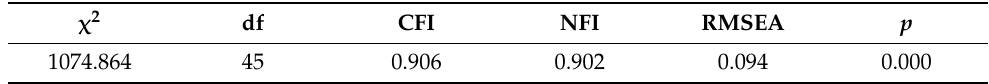
Table 1. Goodness of fit indexes for the structural equation model.